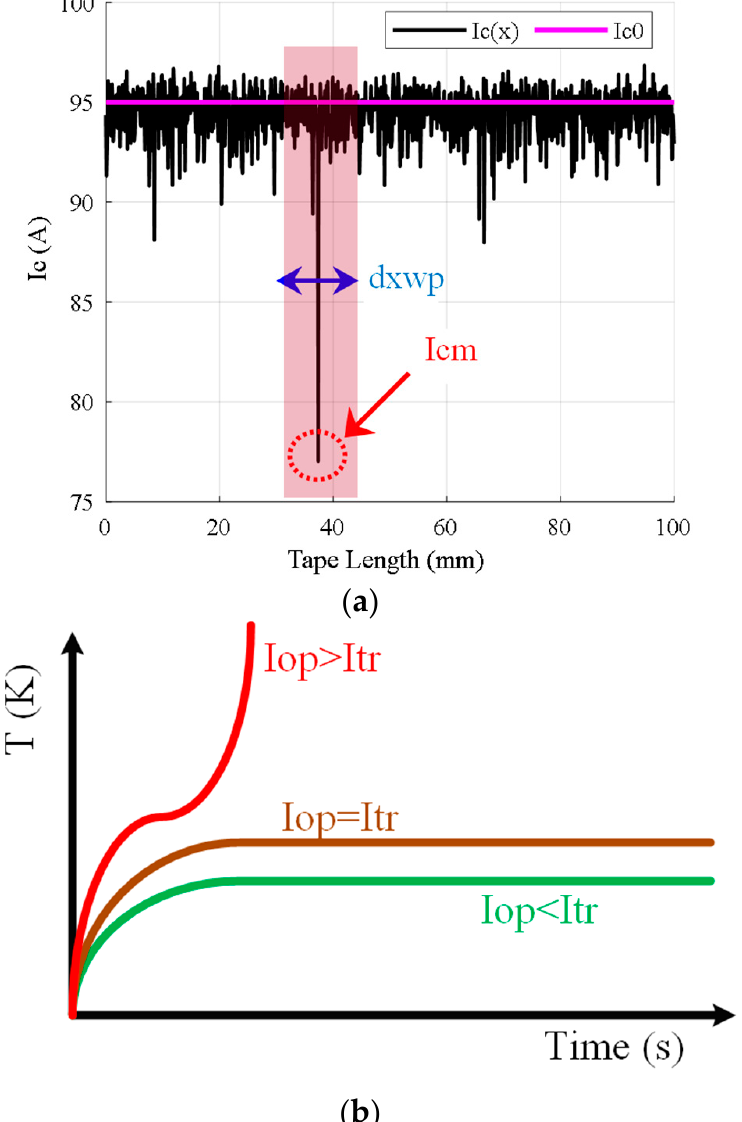
Figure 2. Illustration of different parameters and factors for defining thermal runaway current, ( a ) local critical current of an arbitrary HTS tape. ( b ) Temperature characteristic of HTS tape under different operational conditions and weak points.